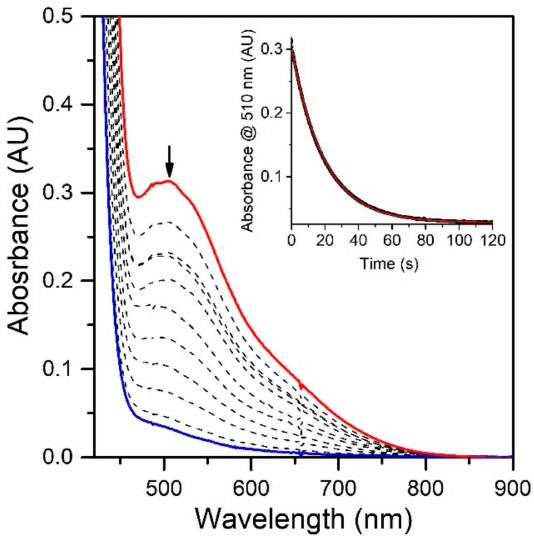
Figure 5. Reactions of 1.25 mM [Mn III (OH)( 6Me dpaq)](OTf) with 10 equiv. TEMPOH at − 35 ◦ C in MeCN (initial and final spectra are the red and blue traces, respectively). Inset: The decay of the 510 nm band over time (black trace) and fit to pseudo-first-order kinetic model (red trace).